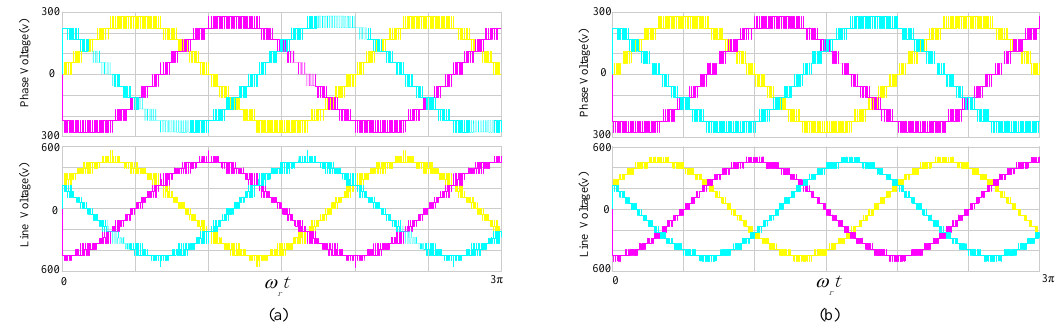
Figure 7. Phase voltage and line voltage for PS-PWM and the optimized new strategy: ( a ) Phase voltage and line voltage for PS-PWM; ( b ) Phase voltage and line voltage for the optimized new strategy.